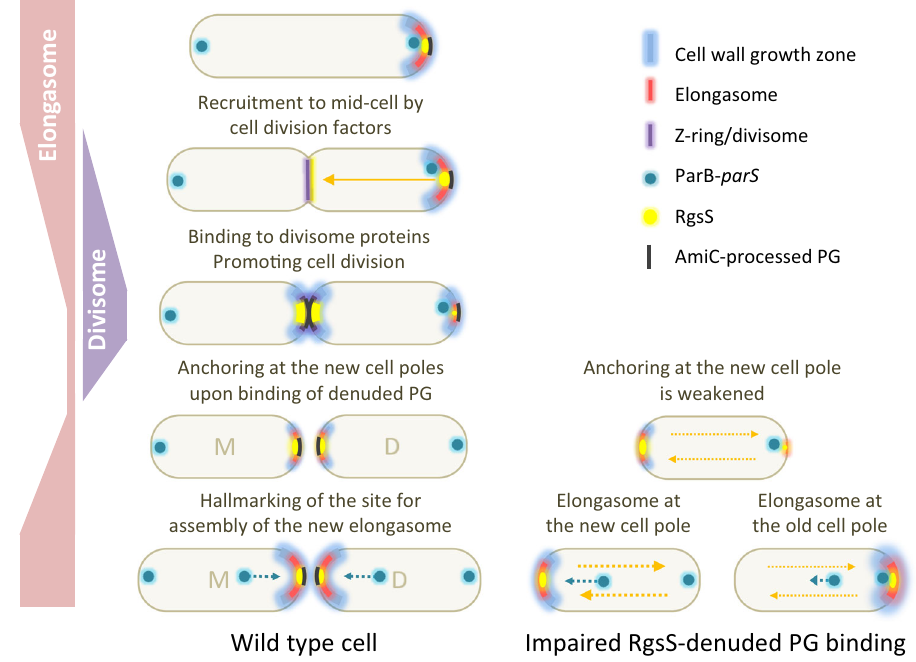
Fig. 6 Proposed role of RgsS-denuded PG interaction in faithful positioning of the polar cell elongation complex at the new cell pole. During cell elongation, RgsS is situated at the growing cell pole and its position is suggested to be stabilized by interaction with AmiC-processed PG. During divisome assembly, RgsS is recruited to mid-cell possibly by one or more divisome components. During cell division, AmiC-processed PG is formed and probably provides binding sites for RgsS. This is assumed to ensure stabilization of RgsS localization at the new cell pole. We propose that RgsS hallmarks the site for assembly of the new elongasome. In the absence of AmiC-processed PG-RgsS binding, anchoring of RgsS at the new cell pole is weakened. Thus, RgsS might accumulate and promote formation of the new elongasome at the old cell